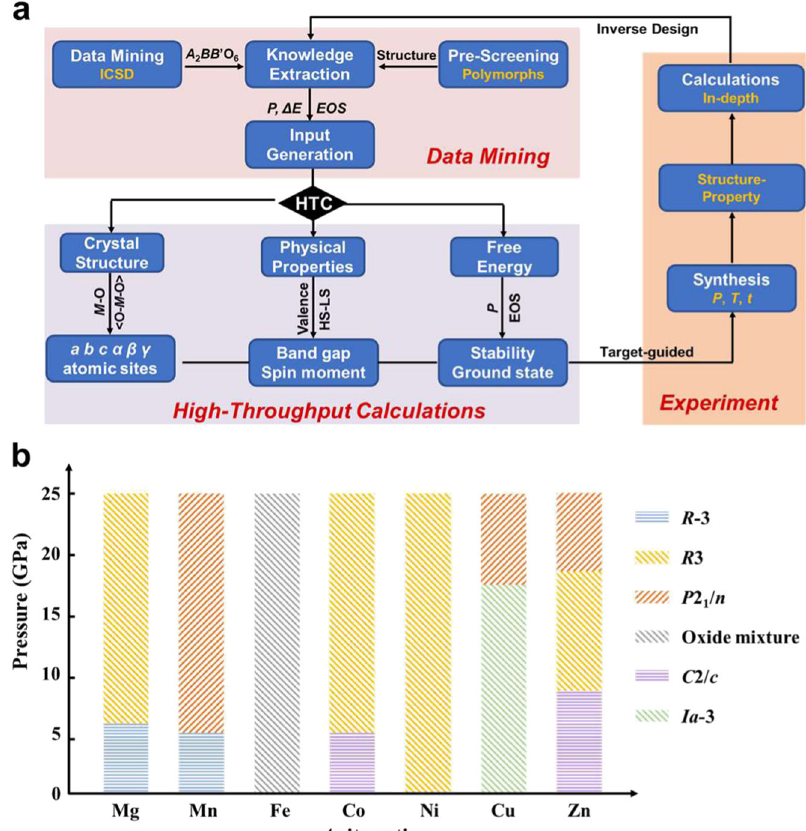
Fig. 1 Discovery of exotic perovskite-related materials via data-driven approach. a The work fl ow of function-oriented searching (composition screening) and designing of new exotic A 2 BB ’ O 6 materials via seamless integration of data mining, high-throughput computing (HTC), and experiment. (1) Data mining: the synthesis conditions and properties of existing polymorphs feed the starting models and input generation for DFT calculations — the starting models and correlated pressure ( P ) effect, Δ E (equivalent to Δ H in fi rst-principles calculations), and equation of state (EOS); (2) HTC: the proposed crystal structure (including unit cell parameters, atomic positions, metal – oxygen bond length ( M – O) and angle (<O – M – O>)), corresponding physical properties (band gap and spin moment in light of the valence state, electron con fi guration of high or low spin (HS – LS) states), and synthesis conditions ( P -dependent energy evolution) enable target-guided synthesis; (3) Experiment: precise synthesis for desired polymorph according to predicted conditions allows in-depth structure – properties and calculations for further inverse design. b Predicted pressure-dependent polymorph evolution of A 3 TeO 6 ( A = Mg 2 + , Mn 2 + , Fe 2 + , Co 2 + , Ni 2 + , Cu 2 + , Zn 2 + ) up to 25 GPa, in which